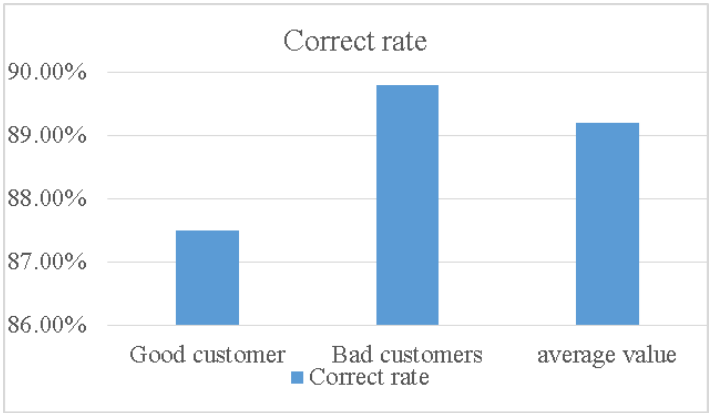
Fig. 2 The prediction accuracy of the model when the cut-off point is